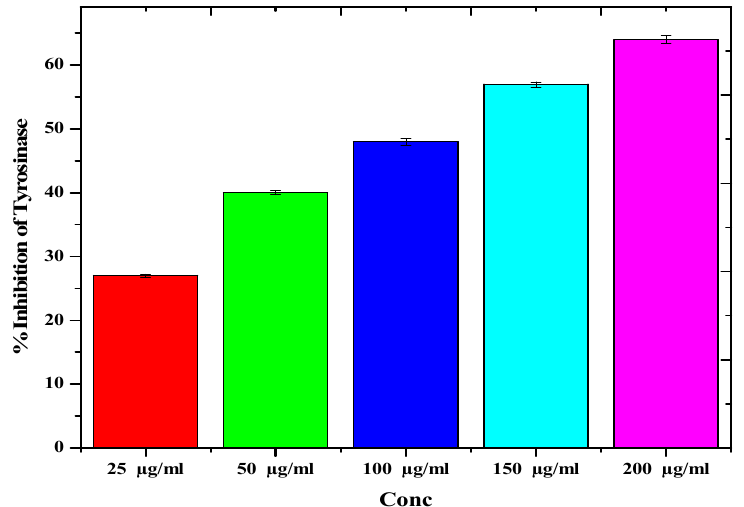
Figure 4. Anti-browning potential of biosynthesized MnO 2 NPs by inhibition of tyrosinase.